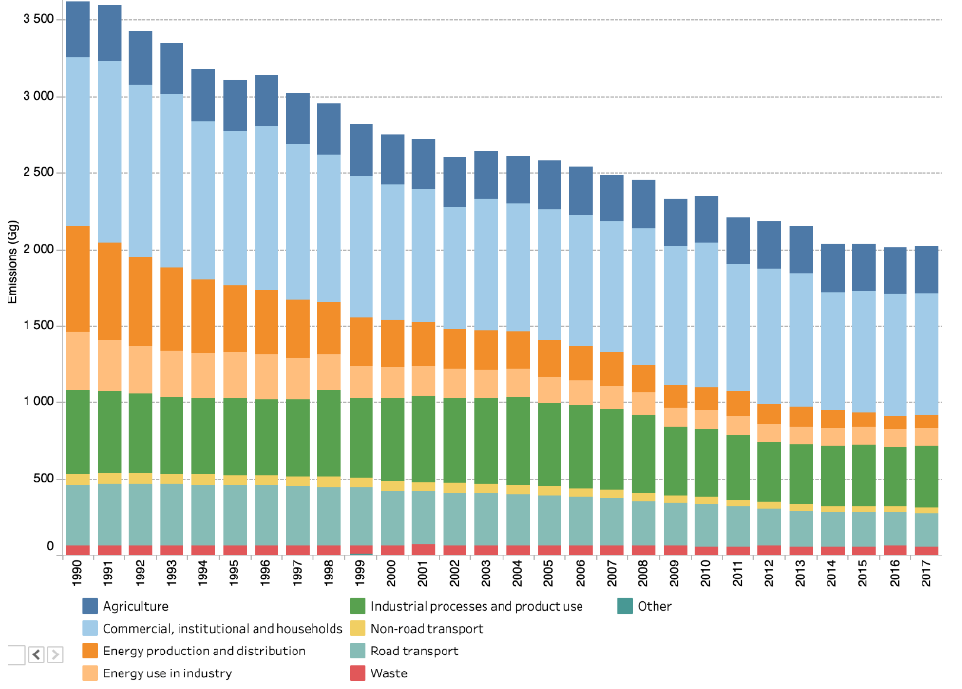
Figure 33. PM 10 emissions by economic sector in Europe (EU-28). Source: European Environment Agency [82].